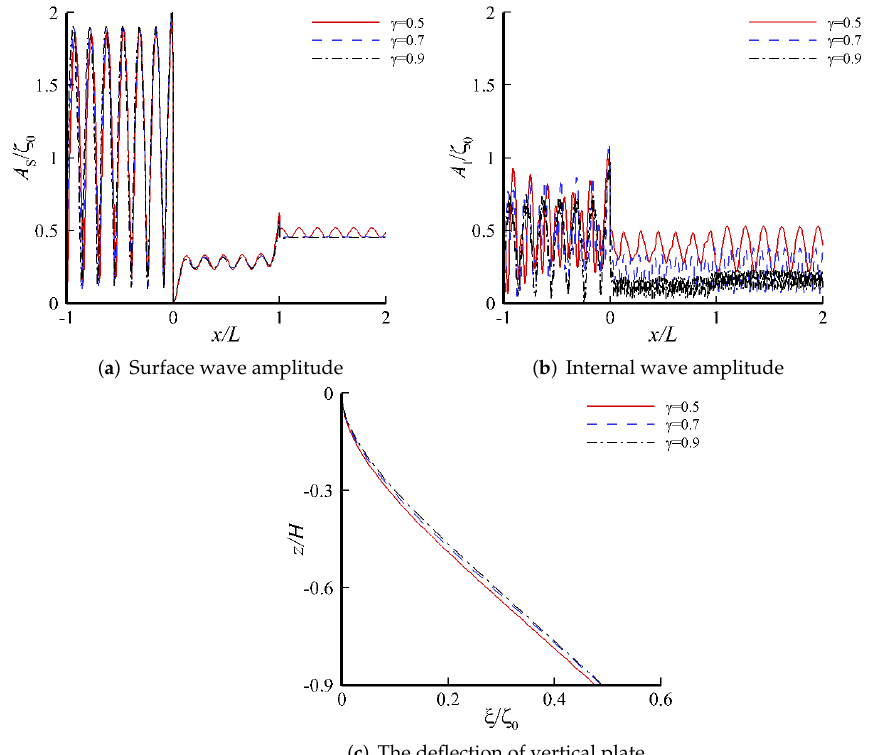
Figure 17. Wave amplitudes A S ( x ) , A I ( x ) and deflection of vertical plate ξ ( z ) for the different density ratio γ